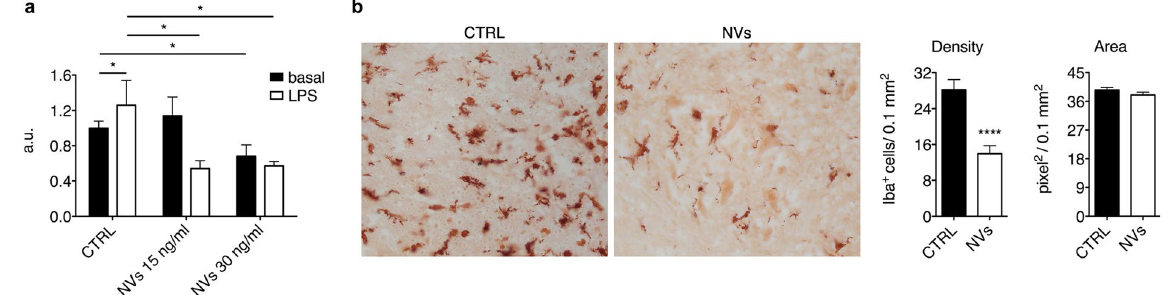
Figure 3. ASC-NVs inhibit microglial cell activation in vitro and in vivo . ( a ) N9 cells were incubated with LPS 100 ng/ml for 24 h and then treated with 15 ng/ml and 30 ng/ml of ASC-NVs for 48 h. ASC-NVs significantly inhibited microglial cell proliferation in vitro (cntrl basal vs cntrl LPS p = 0.035; cntrl basal vs NVs30 p = 0.039; cntrl LPS vs NVs15 p = 0.020; cntrl LPS vs NVs30 p = 0.012). Data are presented as fluorescence arbitrary units (a.u.) relative to the basal condition and are mean ± SD of a representative experiment performed in triplicate. ( b ) Evaluation of microglial activation in the spinal cord spinal cord of PBS (CTRL) or NV-treated EAE mice at disease peak. Activated microglial cells were identified by immunohistochemistry, following staining with anti-Iba-1 antibody. Treatment with NVs strongly inhibited microglial activation in EAE mice, as evident by the reduced number of Iba-1 + cells in the spinal cord of NV-treated animals (p = 8.11E-06). Data are the mean ± SEM of three independent